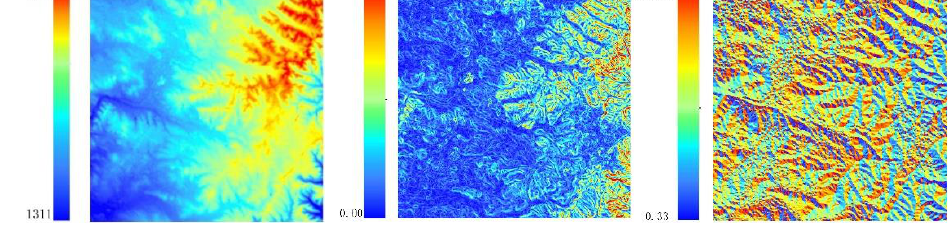
Fig.2.3. the elevation (a), slope (b) and aspect(c) of study